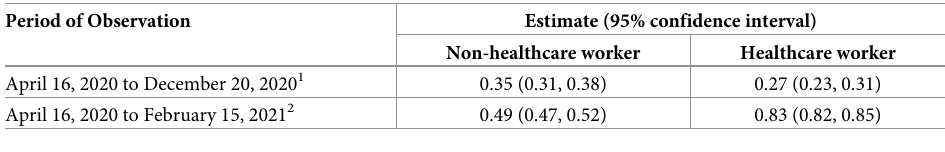
Table 2. Probability of seropositivity according to healthcare worker